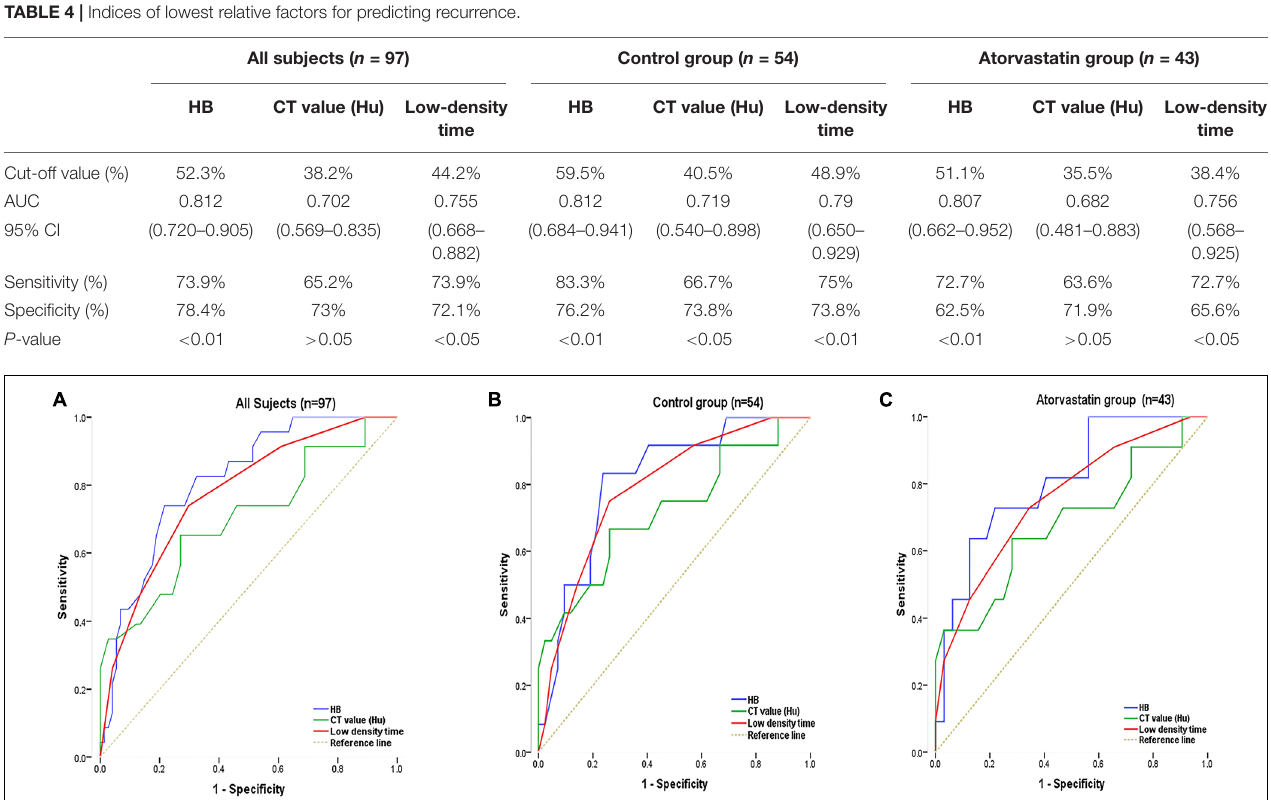
FIGURE 5 | The ROC curve was used to measure the HB, CT value (Hu), and low-density time for predicting the cutoff value of recurrence after surgery. Specificity and sensitivity were used as measures of CSDH recurrence accuracy. Analyses were performed for all subjects in the sample ( A ; n = 97) and separately for the control ( B ; n = 54) and atorvastatin ( C ; n = 43) groups. Chronic subdural hematoma classification recurrence was estimated using the AUC (A–C)